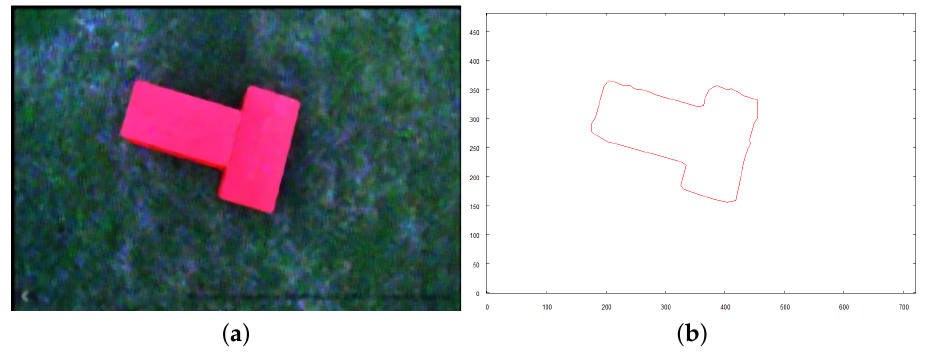
Figure 24. Intermediate steps to obtain vector representation of object B . ( a ) preprocessed image; ( b ) vector representation of object.